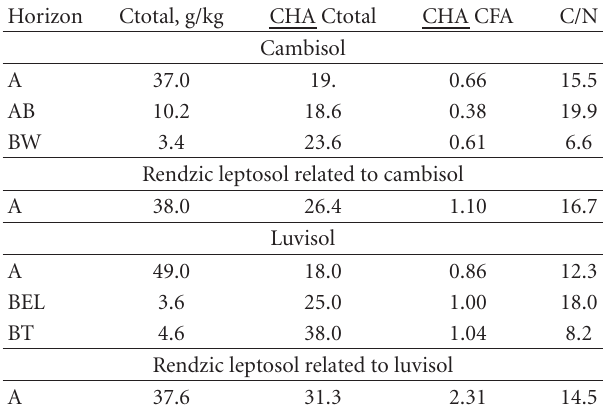
Table 1: Total carbon content, portion of HAs, humus type ratio and humus richness by